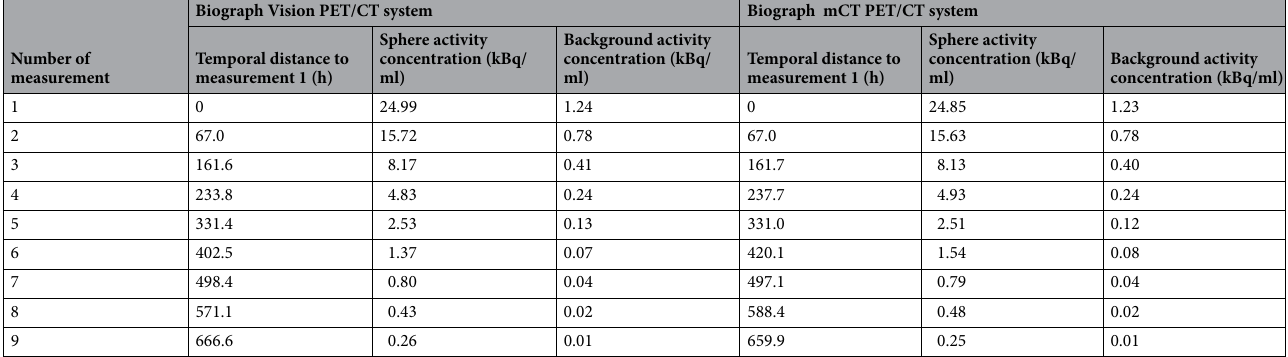
Table 1. Calculated sphere and background activity concentrations for both PET